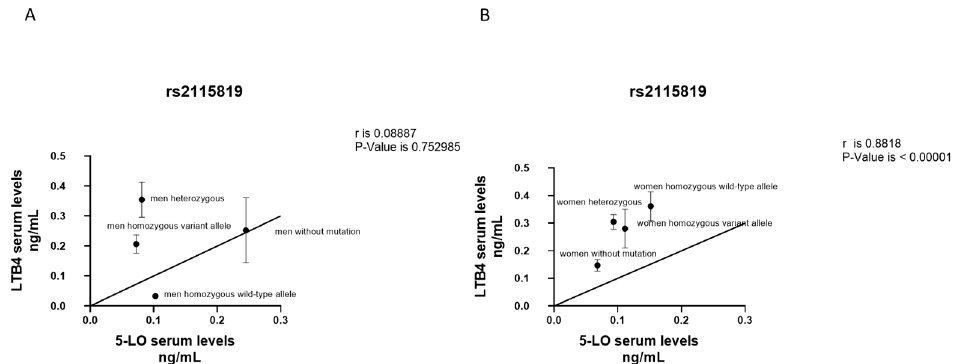
Figure 4. Correlation between LTB4 and 5-LO serum levels according to genotype ALOX5 rs2115819 polymorphism in M ( A ) and W ( B ). Results were shown as means ± SEM. The statistical test used in these analyses was the Pearson correlation test considering 95% confidence interval.